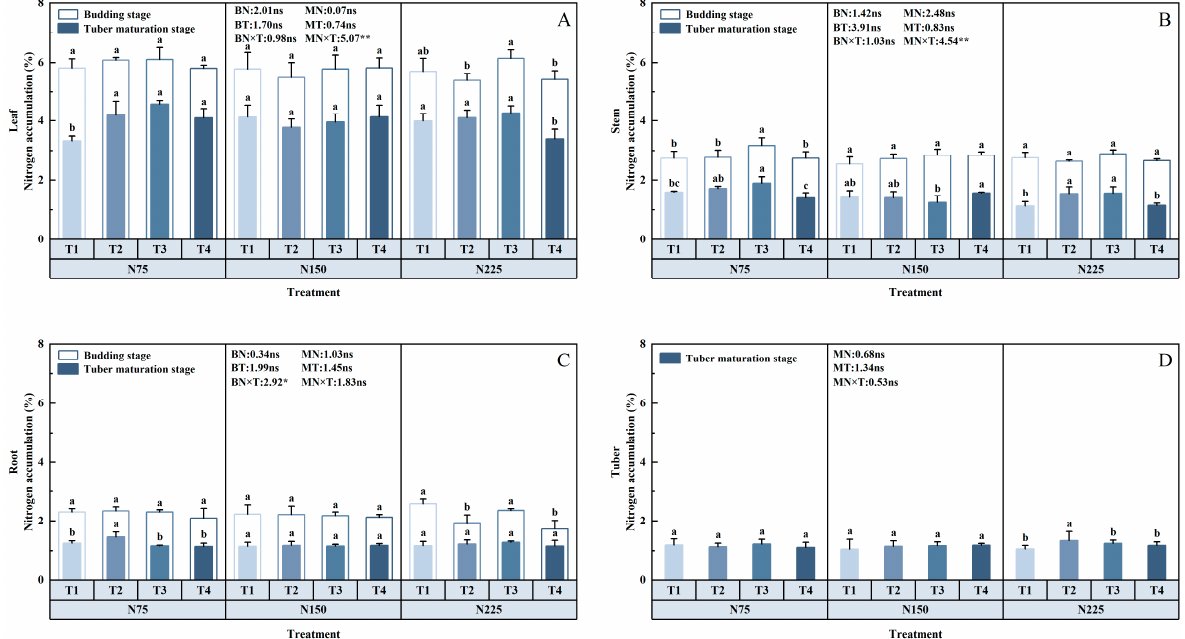
Figure 4. Nitrogen accumulation in leaf ( A ), stem ( B ), root ( C ), and tuber ( D ) at the budding stage (hollow block) and tuber maturation stage (solid block). Capital letter before F-value: B, budding stage; M, tuber maturation stage; N, nitrogen levels; T, base-topdressing ratio. Bars indicate standard errors ( n = 3), and different lowercase letters indicate significant differences between treatments ( p < 0.05). Ns, not significant, * p < 0.05, ** p < 0.01. Table 2. Effects of different nitrogen fertilizer treatments on potato dry matter accumulation in different stages